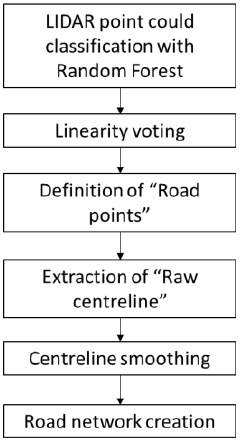
Figure 1. Outline of the proposed workflow for centreline extraction form LIDAR